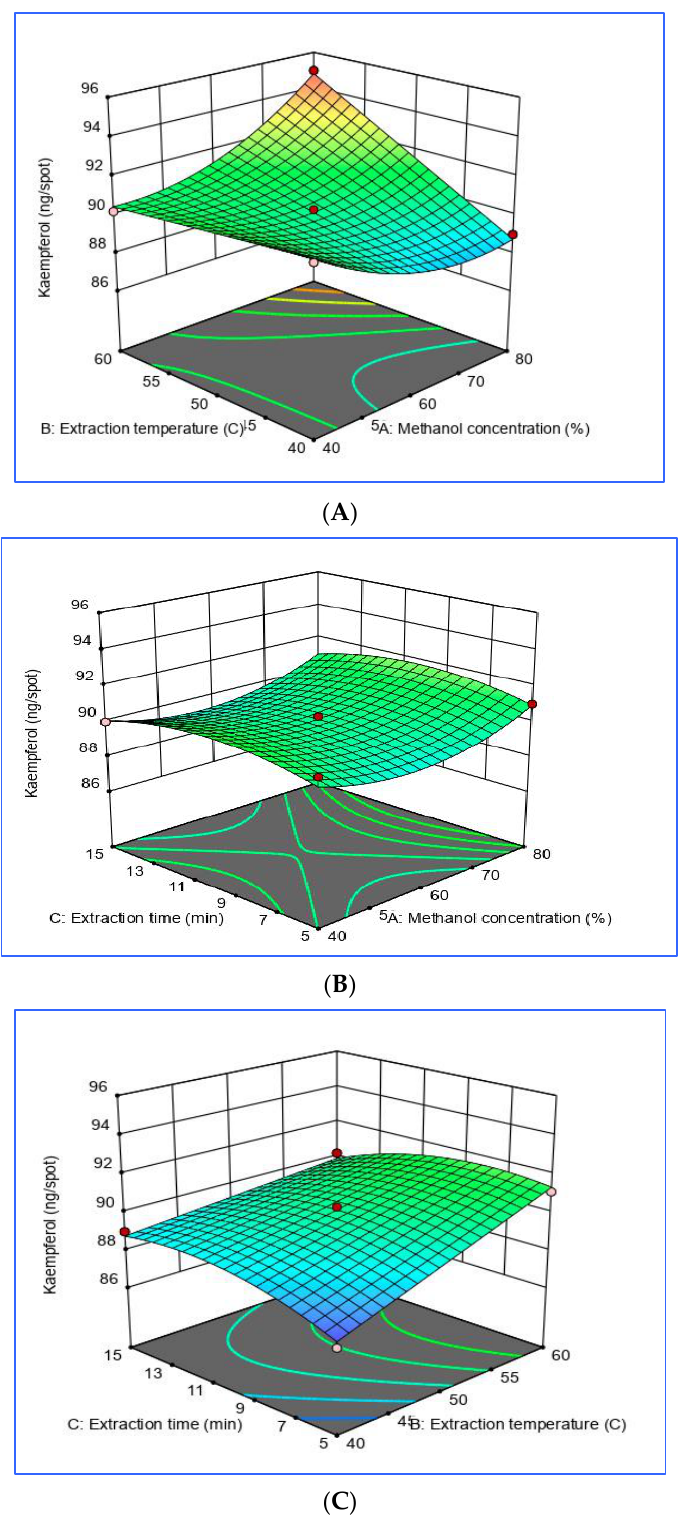
Figure 5. Response surface model 3D plots showing the effects of independent variables of ultrasonicated Ocimum basilicum on KA yield. ( A ) Methanol concentration and extraction temperature, ( B ) methanol concentration and extraction time, and ( C ) extraction temperature and extraction time.